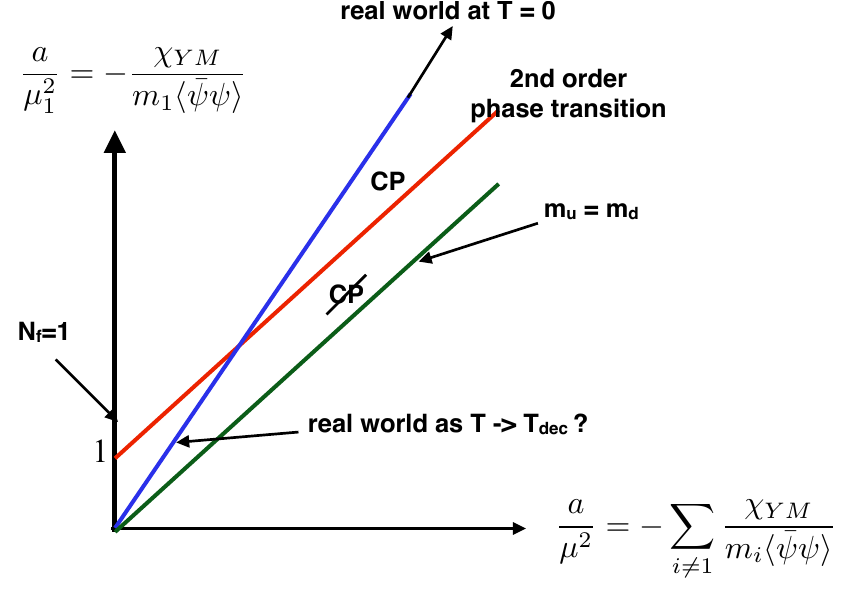
Figure 10 . Phase diagram for N f = 2. The red line separates the phases with broken and unbroken CP at (cid:18) = (cid:25) and corresponds to a second-order transition with a massless particle. For m d (cid:29) m u we recover the N f = 1 case represented by the vertical axis. Also shown is the m u = m d case lying entirely in the CP broken phase. The real world at T = 0 is far up on the blue line (representing m d (cid:24) 2 m u ). As T is increased towards T dec the real world will stay on the blue line (since m d =m u is T -independent) but may move down and cross the red line as indicated in the picture.